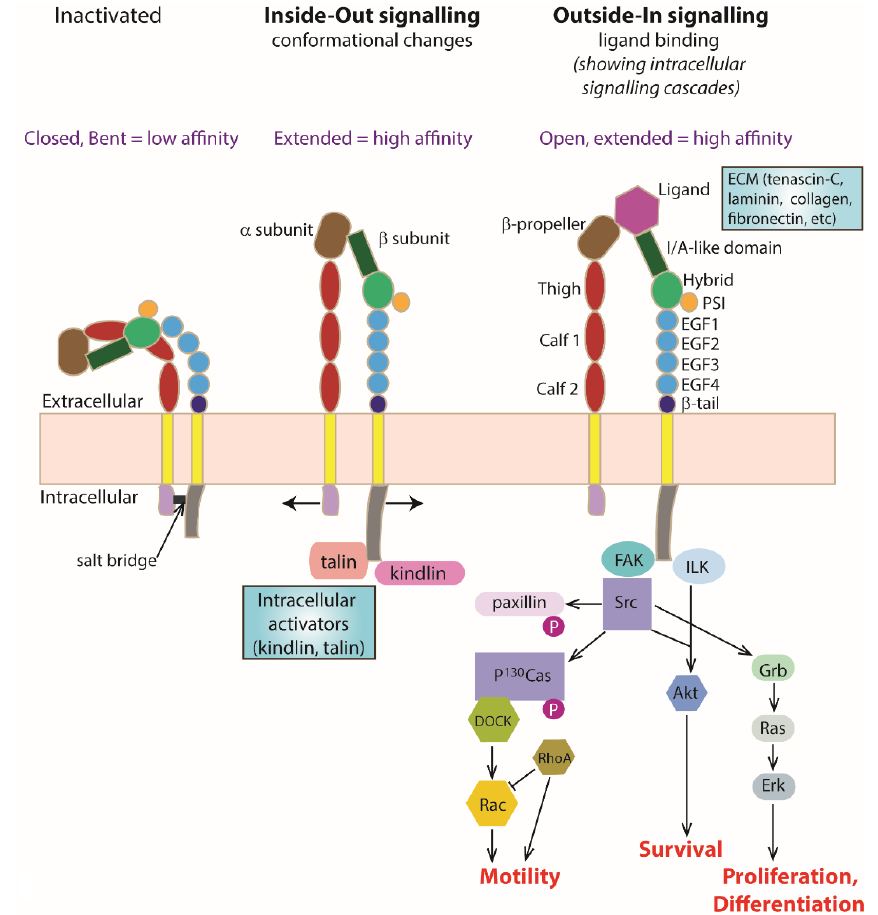
Figure 1. Integrin Structure and Activation. Activation of integrin heterodimers leads to intracellular signalling cascades and resulting processes such as cell motility, cell survival, cell differentiation, cell differentiation and neurite outgrowth. Schematic representing integrin conformations at the membrane including changes that occur with ‘Inside–Out signalling’ and ‘Outside–In signalling’. An inactivated integrin heterodimer exists with a closed and bent conformation (extracellularly) stabilised by a cytoplasmic salt bridge. This conformation has a very low ligand binding affinity. With Inside–Out signalling, intracellular activators (such as kindlin and talin) bind the β subunit cytoplasmically and interact/destabilise the salt bridge, leading to an open and extended (active) conformation with increased ligand binding affinity. With Outside–In signalling, binding of a ligand (ECM molecules such as laminin, fibronectin, or tenascin) extracellularly occurs as a result of integrin activation leading to a conformational change to an open and extended (active) conformation with high ligand binding affinity. Individual names of the extracellular domain components have been shown in the Outside–In signalling example for simplicity, with further explanation in the main text. Integrins are bidirectional signalling molecules. They exist in either the inactivated or activated state. It has been suggested that integrins are transported to the plasma membrane from the